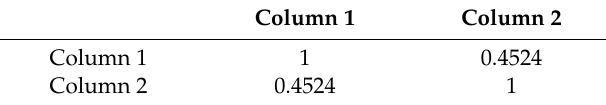
Table A7. Spearman correlation (see Table